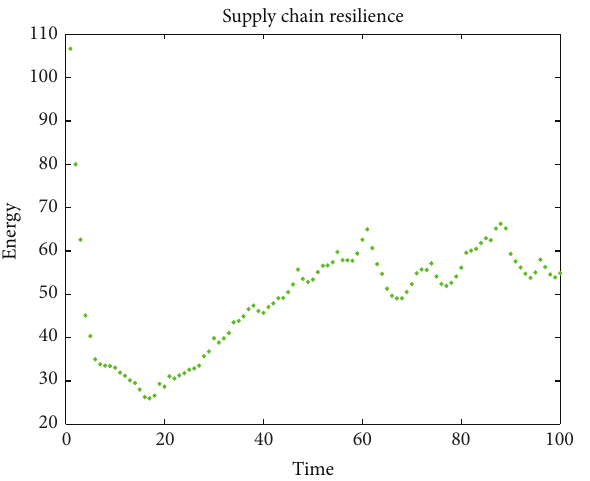
Figure 13: There is resilience within SOC/number 5.